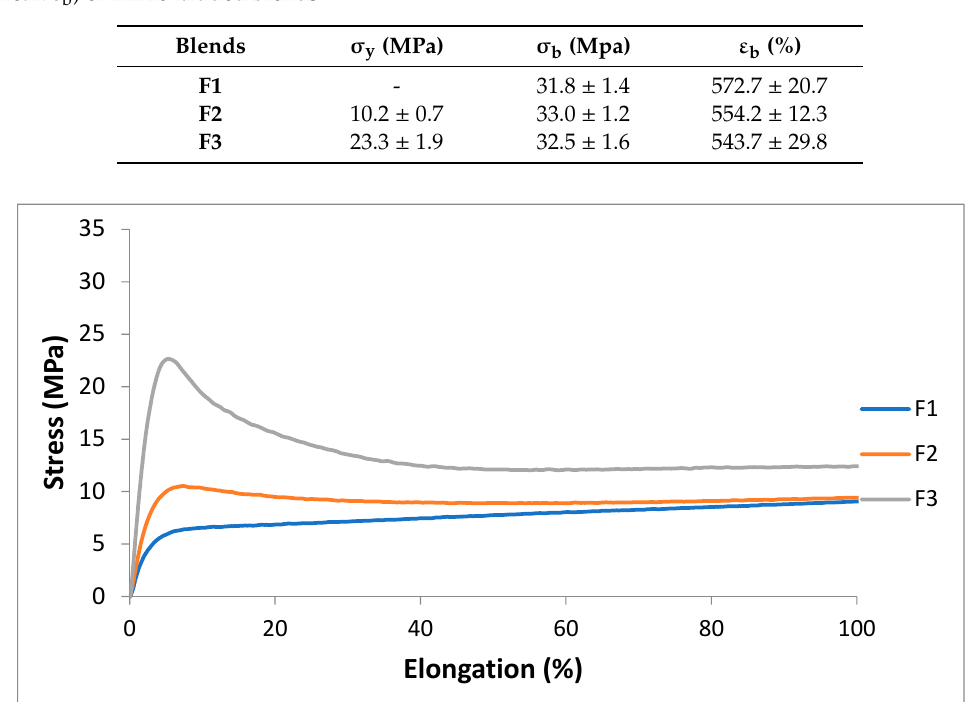
Table 5. Tensile properties (stress measured at the break point σ b , stress at yield ( σ y ) and elongation at break ε b ) of miniextruded blends.